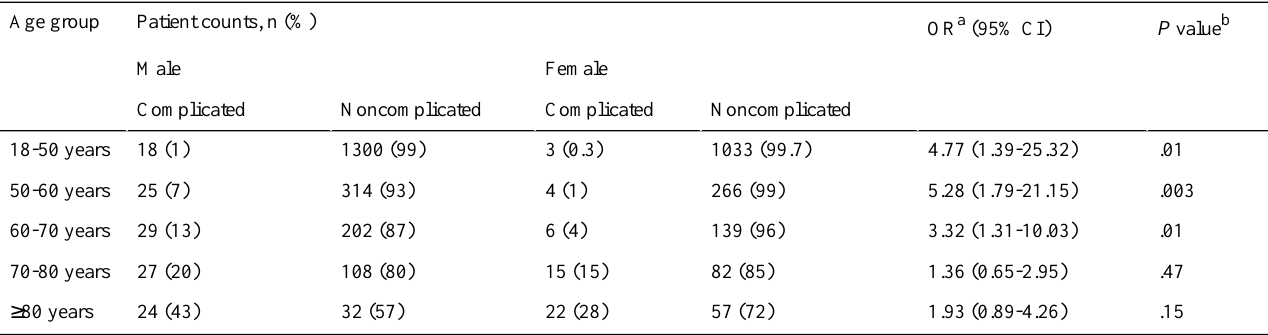
P value b OR a (95% CI)Patient counts, n (%)Age group